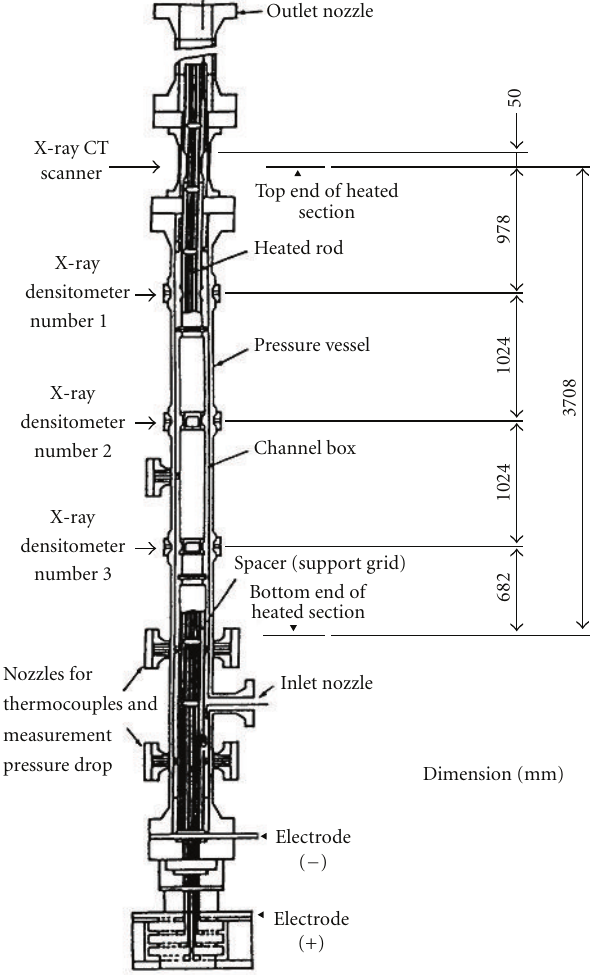
Figure 1: Vertical cut of the NUPEC BFBT test